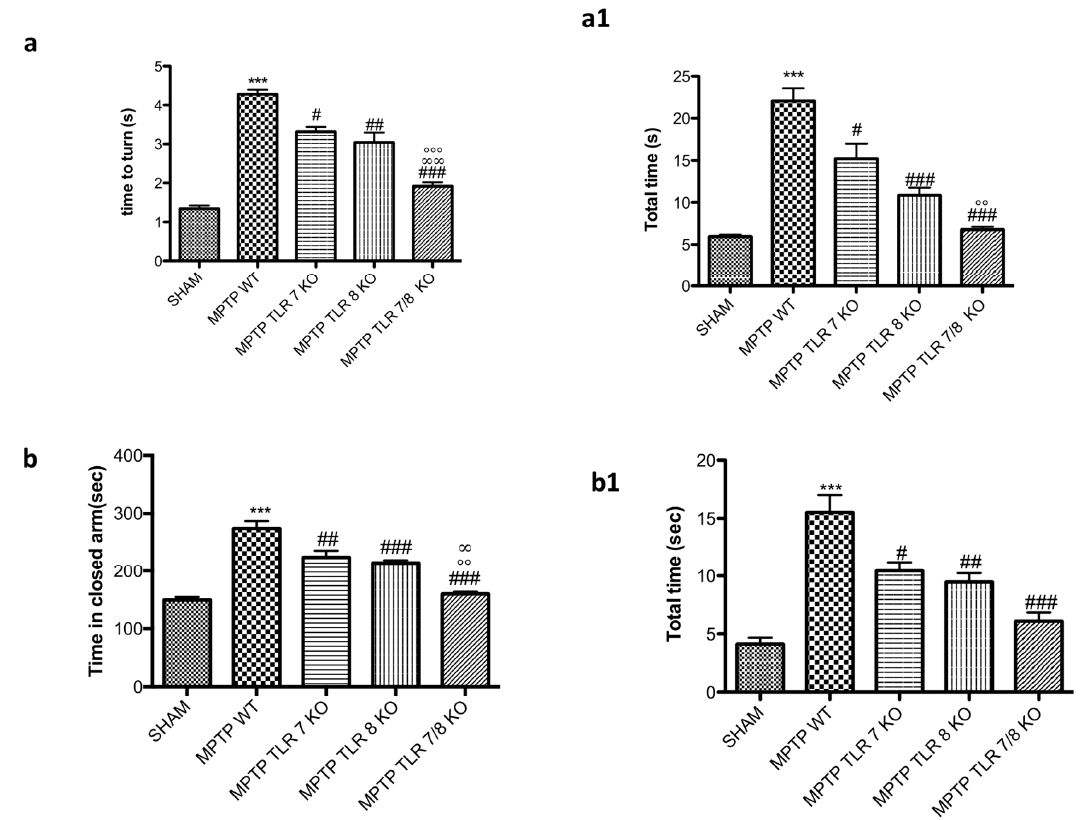
Figure 4. E ff ect of TLR7 / 8 on behavioral alteration induced by MPTP. “Time to turn” and “Total time” were significantly increased after injection of MPTP in WT mice compared with the control group ( a , a1 ); TLR7 and 8 KO mice showed a reduction of both “time to turn” and “total time” ( a , a1 ), with a significant reduction in the double TLR7 / 8 KO mice ( a , a1 ). Values are mean ± SEM of 10 mice for each group. *** p < 0.001 vs. SHAM WT; # p < 0.05 vs. MPTP WT; ## p < 0.01 vs. MPTP WT; ### p < 0.001 vs. MPTP WT; ◦◦ p < 0.01 vs. MPTP TLR7KO; ◦◦◦ p < 0.001 vs. MPTP TLR7KO; ∞ ∞ p < 0.01 vs. MPTP TLR8 KO. The e ff ect of the absence of receptors TLR7 and 8 on anxiety behaviors was evaluated by elevated plus maze (EPM) test ( b , b1 ). Anxiety was expressed as mean total entries in the open arms and number of entries in open arms. MPTP mice stand more time in the closed arms compared to SHAM animals ( b , b1 ), whereas TLR7 and 8 KO mice and much more TLR 7 / 8 KO mice showed a reduction of time spent in closed arms ( b , b1 ). Data are means ± SEM of 10 mice for each group. *** p < 0.001 vs. SHAM WT; # p < 0.05 vs. MPTP WT; ## p < 0.01 vs. MPTP WT; ### p < 0.001 vs. MPTP WT; ◦◦ p < 0.01 vs. MPTP TLR7KO; ∞ p < 0.05 vs. MPTP TLR8 KO.